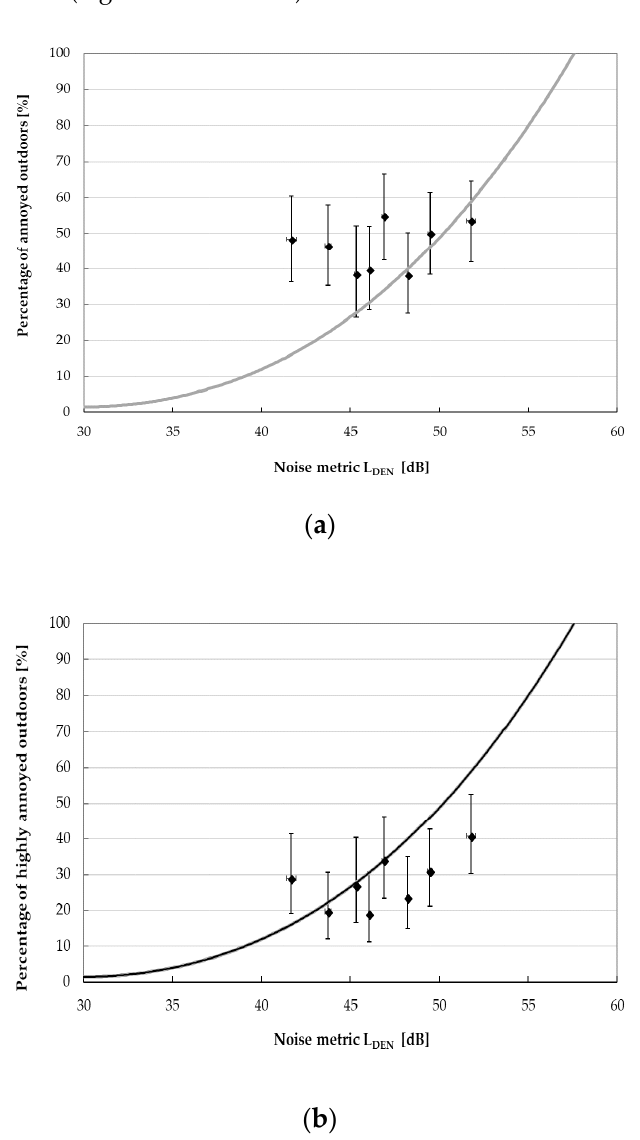
Figure 11. Comparison of observed proportions (with 95% confidence levels) of respondents being ( a ) annoyed and ( b ) highly annoyed outdoors by the wind turbine noise to exposure-response relationships for wind turbine annoyance outdoors proposed by Janssen et al. Dots with whiskers represent survey data with 95% confidence intervals.